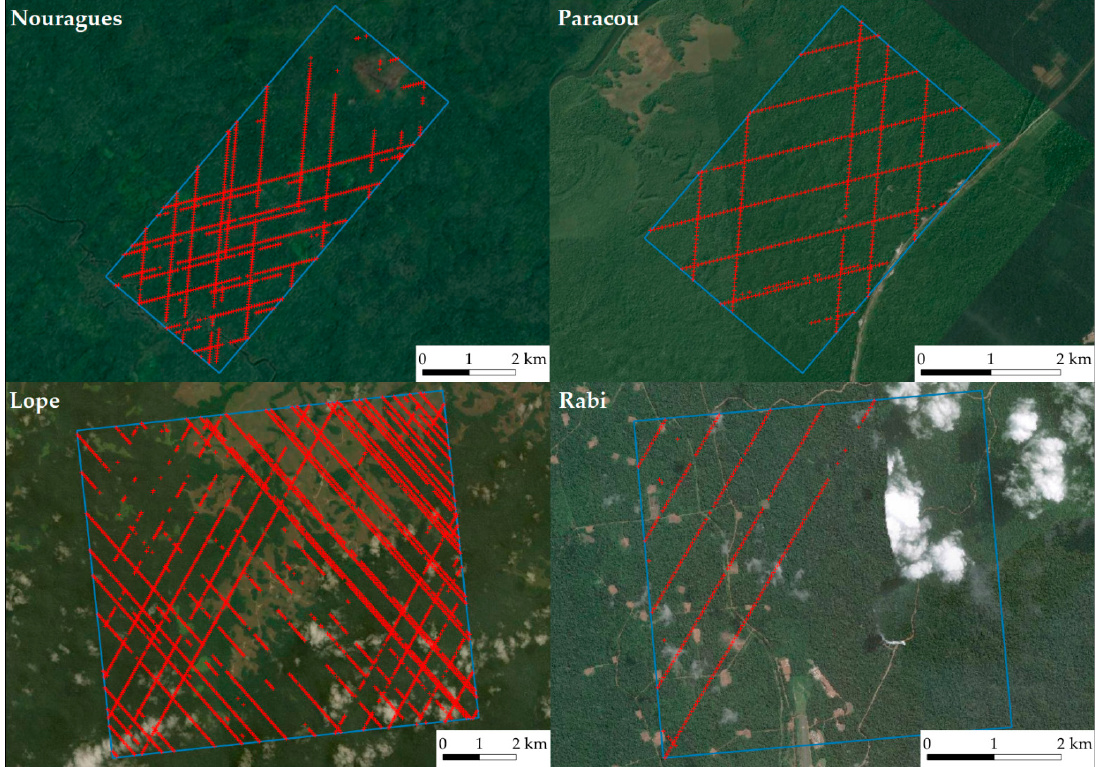
Figure 2. ALS acquisition areas (blue) and filtered GEDI footprints (red) over the four study sites (ESRI Satellite ® ).